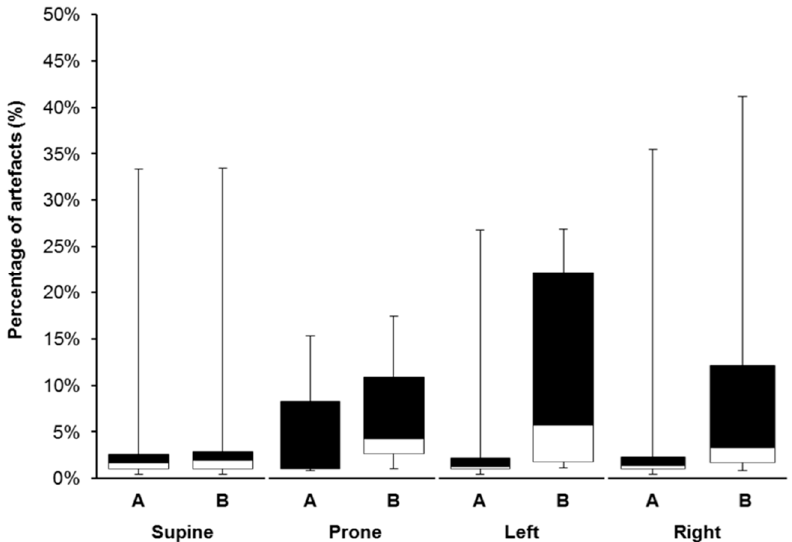
Figure 6. Influence of body position on the occurrence of artefacts for RR-interval measurements using gel electrodes and the ECG-belt. The influence of body position (supine, prone, left body side, right body side) on measurement quality is presented. Data relate to 13 or fewer applications of a belt. A, gel electrodes; B, ECG-belt. Supine, patient lying on the back; prone, patient lying on the chest; left and right, patient lying laterally Black part of boxes indicates upper quartile; white part of boxes indicates the lower quartile. Whiskers represent data for maximal values.